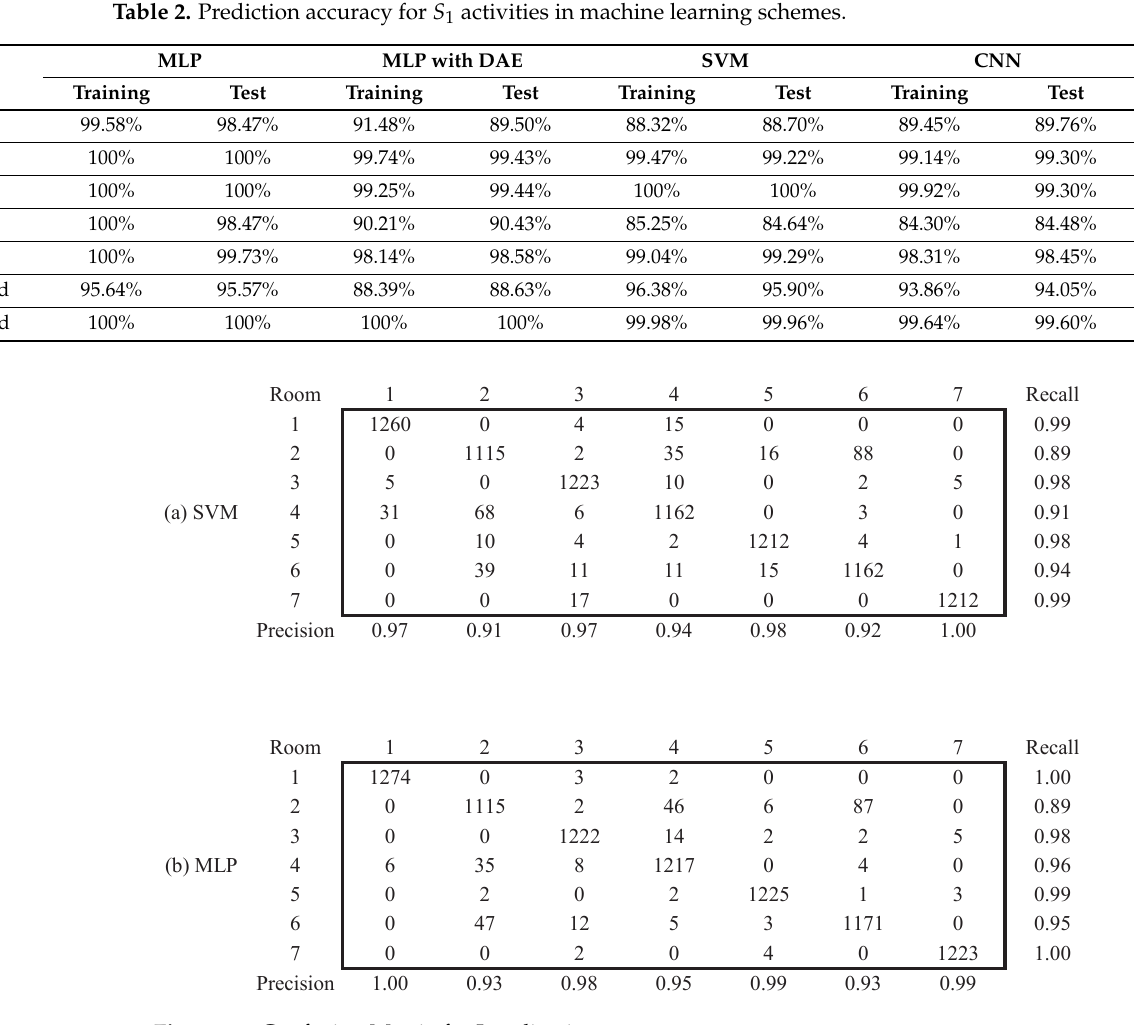
Figure 12. Confusion Matrix for